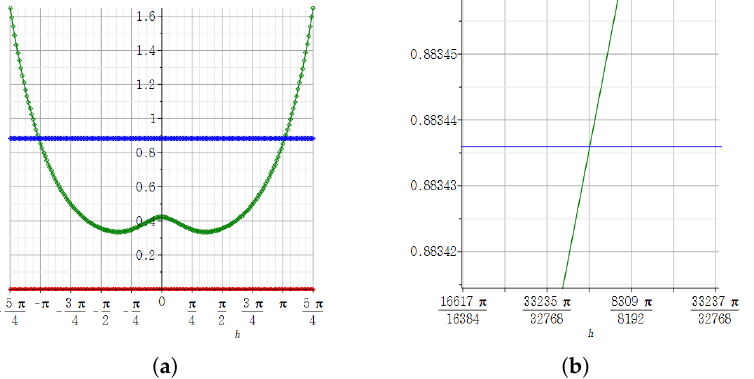
Figure 10. ( a ) shows the result of the imaginary part of the step derivatives of sin z at z 0 according to the size of h by using the Maple plot. ( b ) In the graph of ( a ), the result of zooming in about h near π . In ( a , b ), the green graph represents the imaginary part of the ( j , k ) -step derivative, the red graph represents the imaginary part of the j -step derivative of cos z at z 0 according to the size of h , and the blue constant graph represents the imaginary part of the derivative of sin z at z 0 by the definition of the derivative for a complex system.